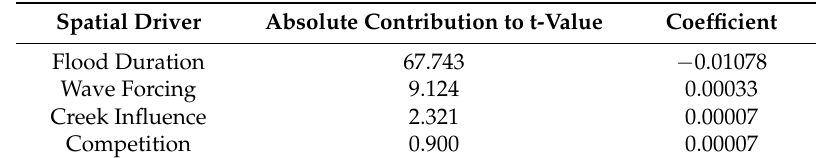
Table 5. The contribution to the t value in the multiple-regression model relating spatial drivers with leaf area index.